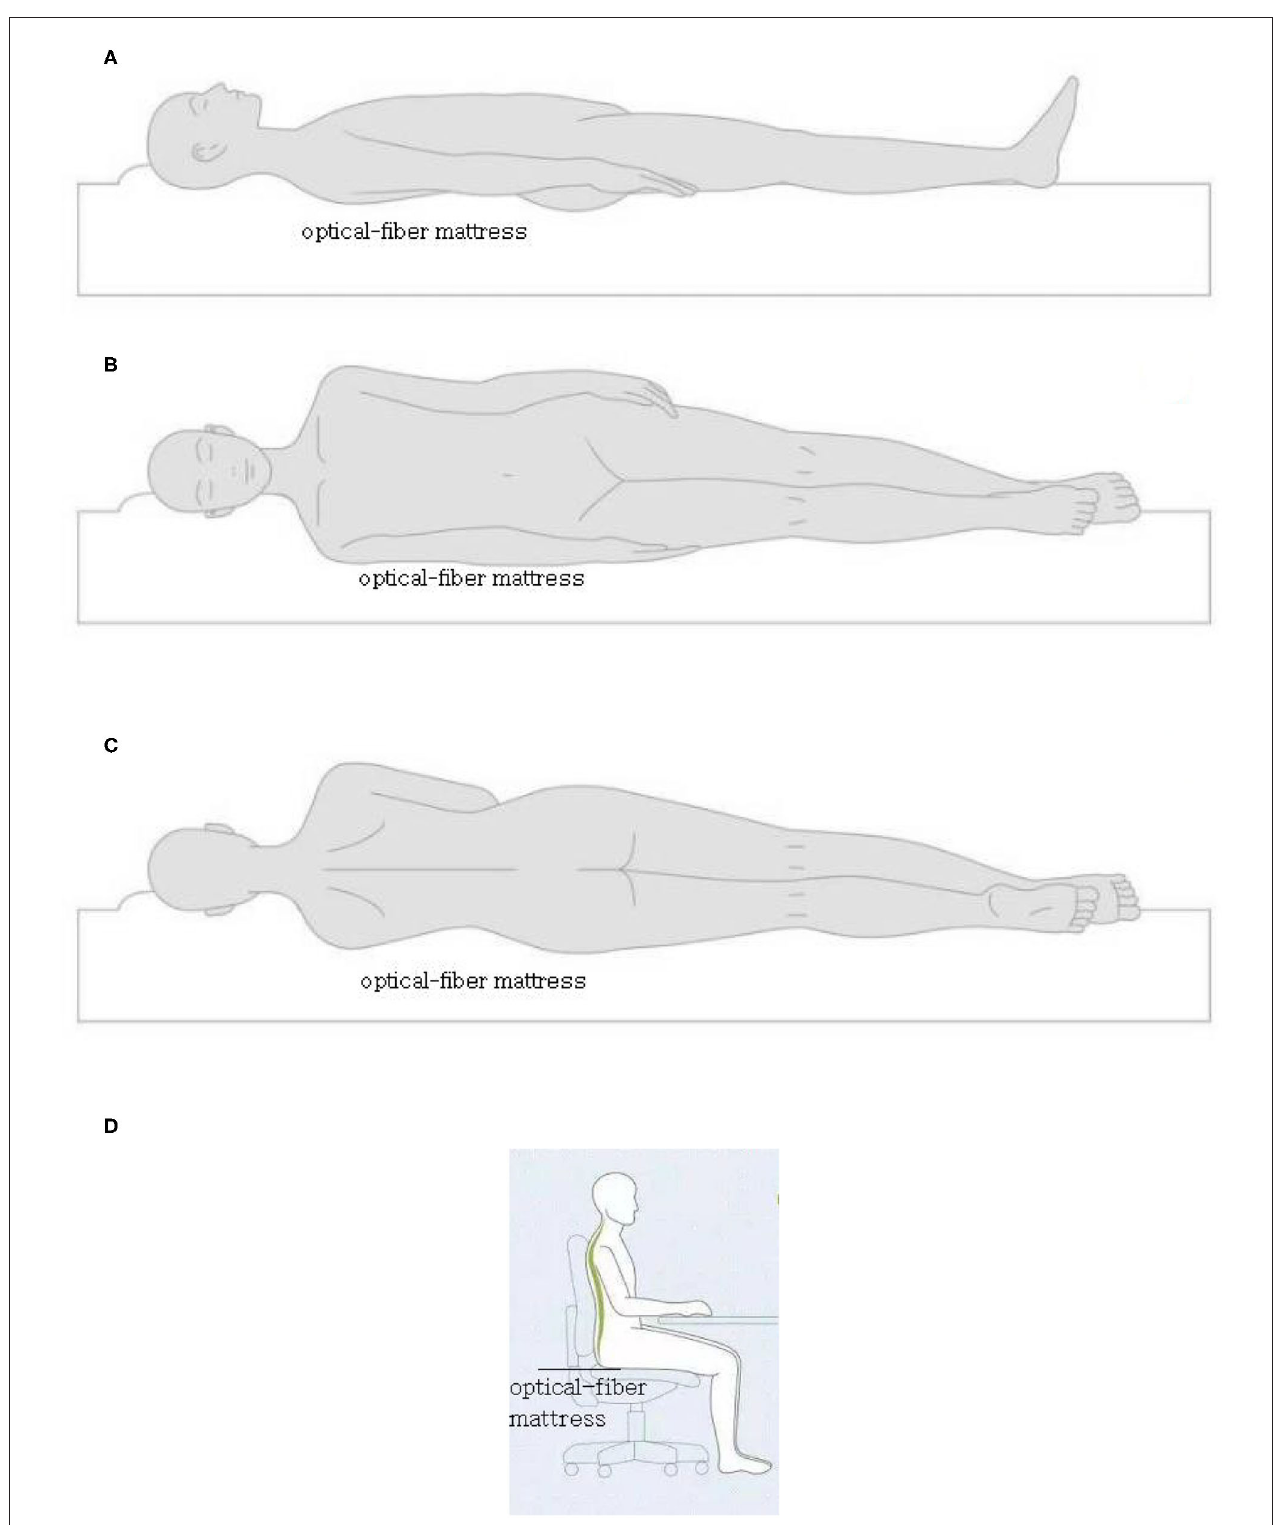
FIGURE 12 | The four postures of the back (A) (near the chest), left (B) , right (C) , and sitting (D) (near the hips).